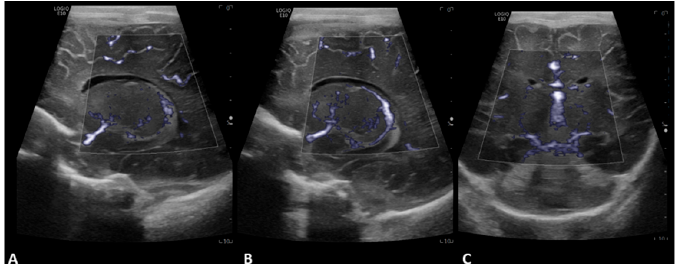
Figure 2. A 2-day-old boy with no history of congenital cardiac disease underwent ECMO due to acute hypoxemic respiratory failure. Brain MVI was performed after three days from cannulation; grayscale US was normal. Left ( A ) and right ( B ) parasagittal, and coronal ( C ) brain MVI demonstrated symmetric decreased blood flow in the basal ganglia.